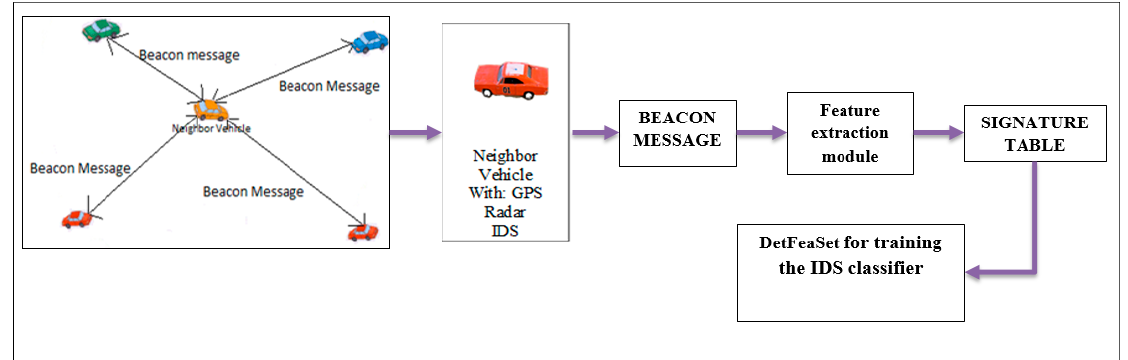
Figure 3. Vehicle receives beacon messages from neighbor vehicles.